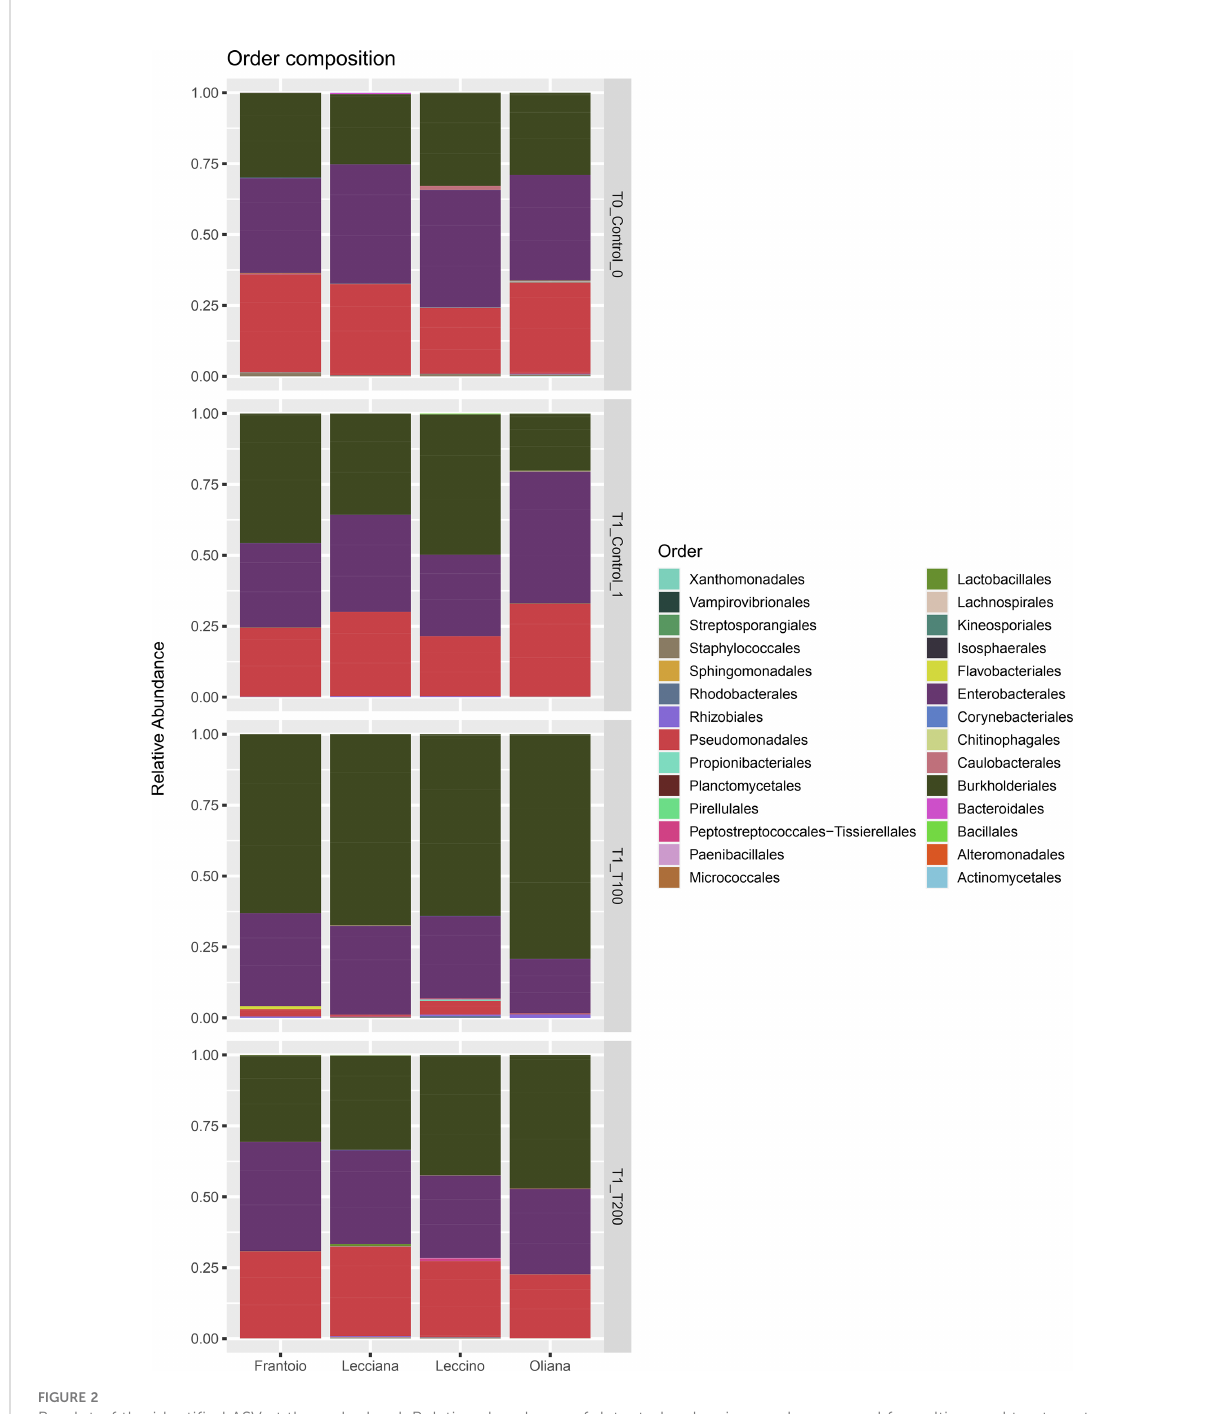
FIGURE 2 Barplot of the identi fi ed ASV at the order level. Relative abundance of detected orders in samples grouped for cultivar and treatment. Represented ASVs were fi ltered (threshold = 0.5%) to display only signi fi cant